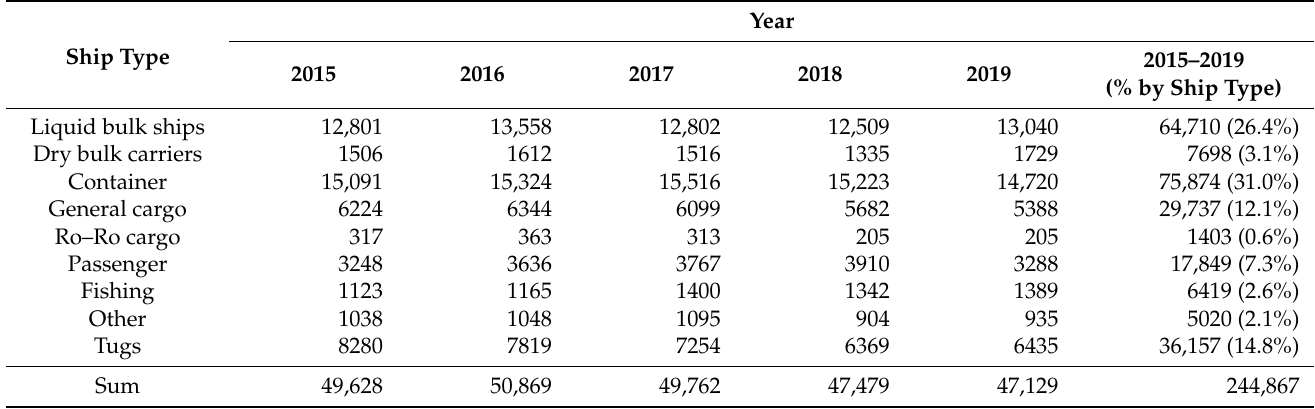
Table 8. Ship entry number 1 by ship type at Busan Port from 2015–2019 [num].